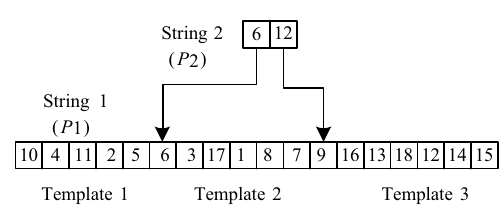
Fig. 2 Two strings for the allocations of 18 labels in 3 template